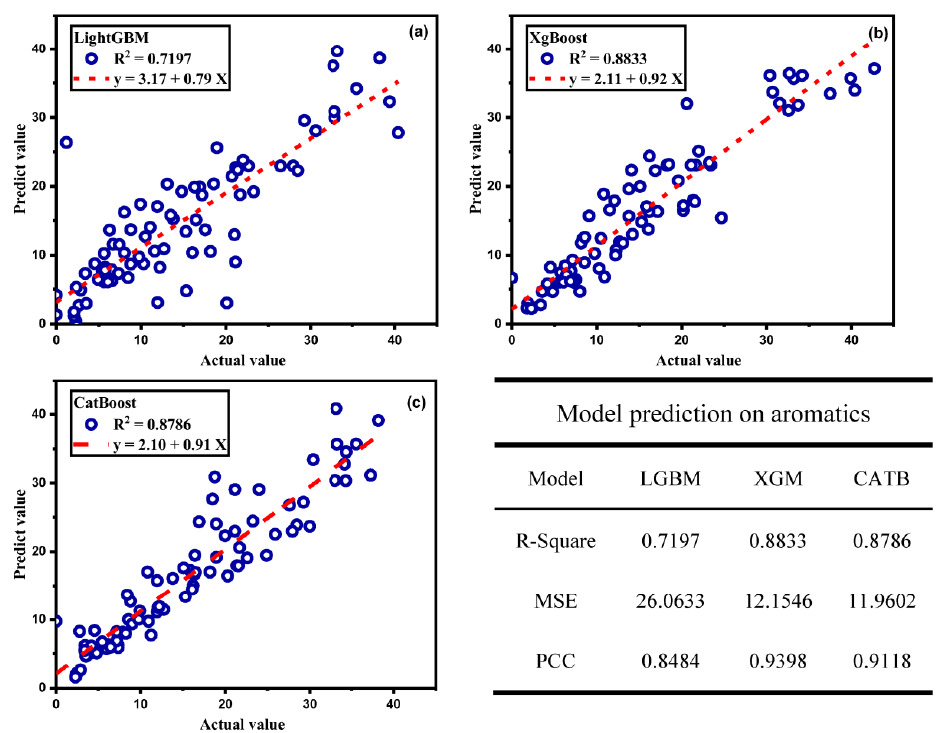
Figure 4. Aromatics yield prediction curve and prediction score of ( a ) LightGBM, ( b ) XgBoost, ( c ) CatBoost and table of machine learning evaluation results.